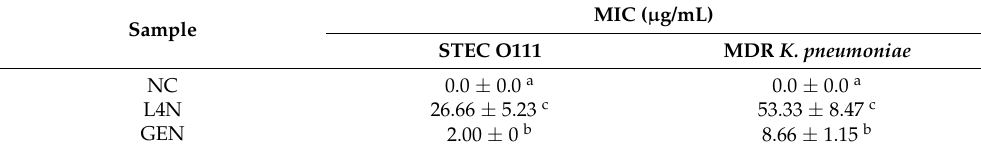
Table 3. MIC of luteolin 4 (cid:48) -neohesperidoside (L4N) against MDR E. coli O 111 and MDR K. pneumoniae .